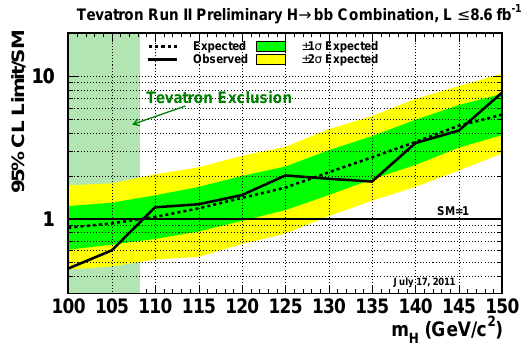
Fig. 6. Observed and expected 95% C.L. upper limits on the ratio to the SM prediction for the H b ¯ b decay. The bands indicate → the 68% and 95% probability regions where the limits can fluctu- ate, in the absence of signal.